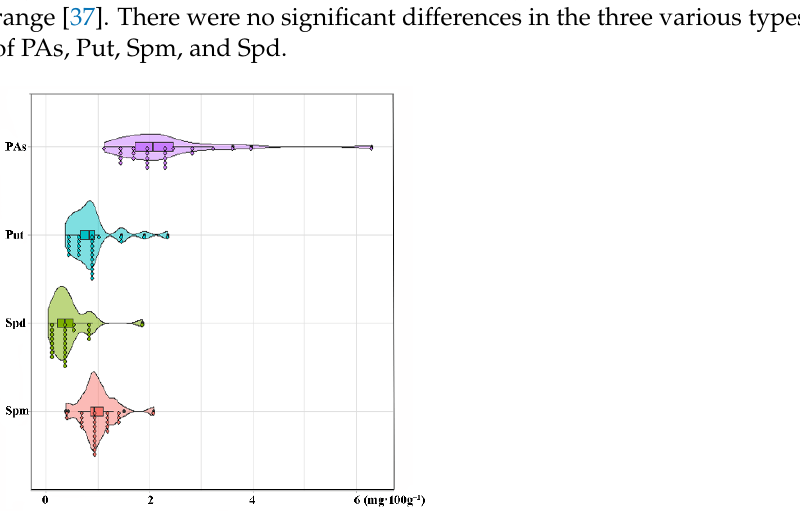
Figure 4. The cultivar variation in polyamine content and composition. PAs, total polyamines; Put, putrescine; Spm, spermine; Spd, spermidine.